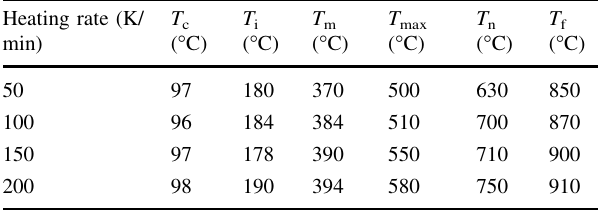
Table 4 Characteristics temperature in TG/DTG curves of low rank coal at different heating rate Heating rate (K/ min)